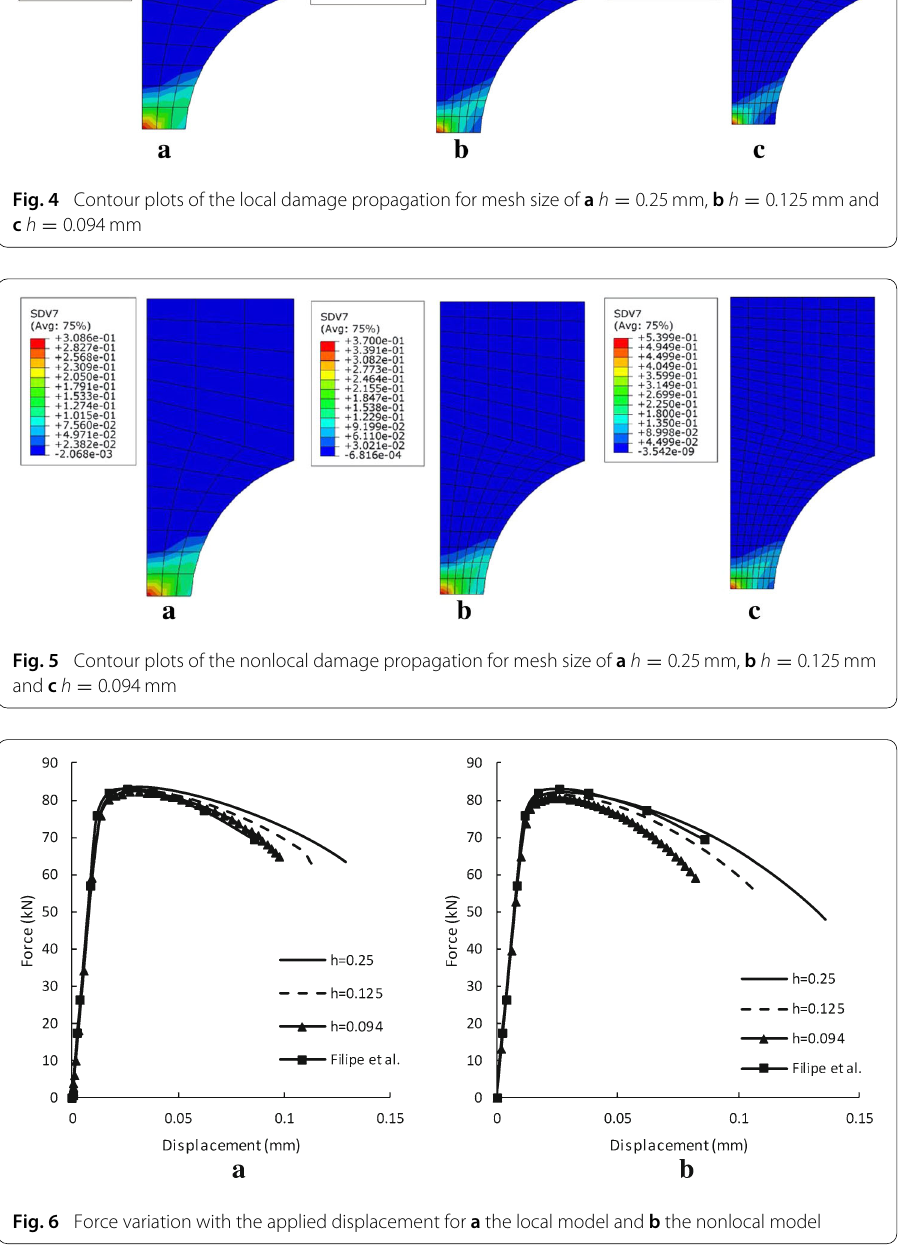
uses the built-in heat equation solver, by making quantitative comparisons with existing data in